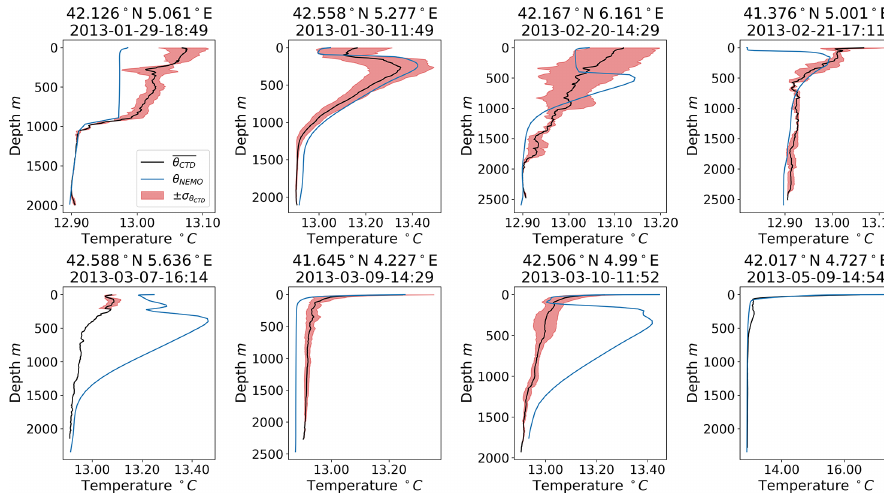
Figure 6. The same as Fig. 5 but for potential